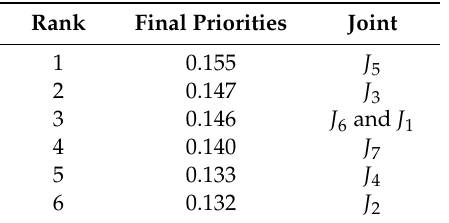
Table 6. Rank of joints (alternatives) and their